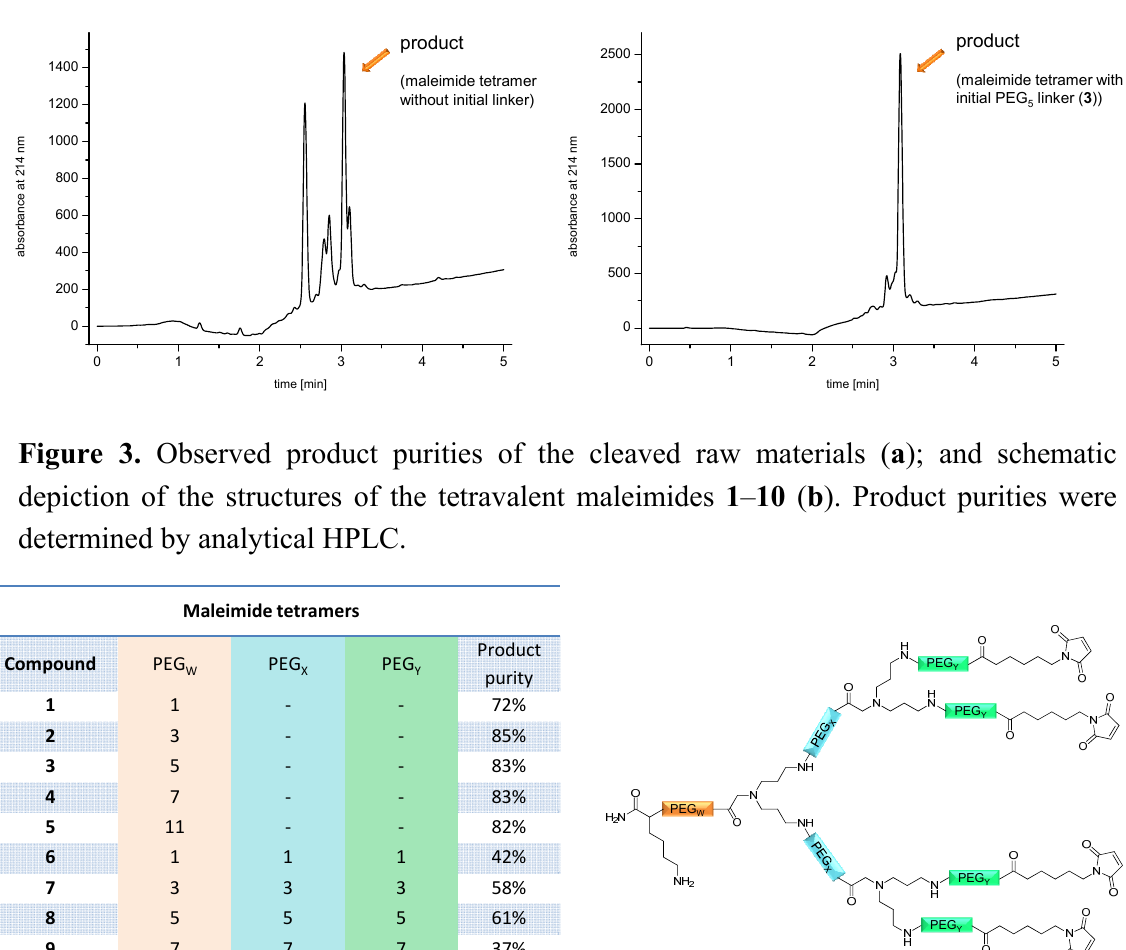
Figure 2. Analytical HPLC traces of the raw materials of a tetravalent maleimide synthesized on a standard rink amide resin comprising no OEG linker ( left ) or on a low-loading resin implementing a PEG -linker ( right ) between the initially conjugated 5 lysine and the focal point of the dendron.